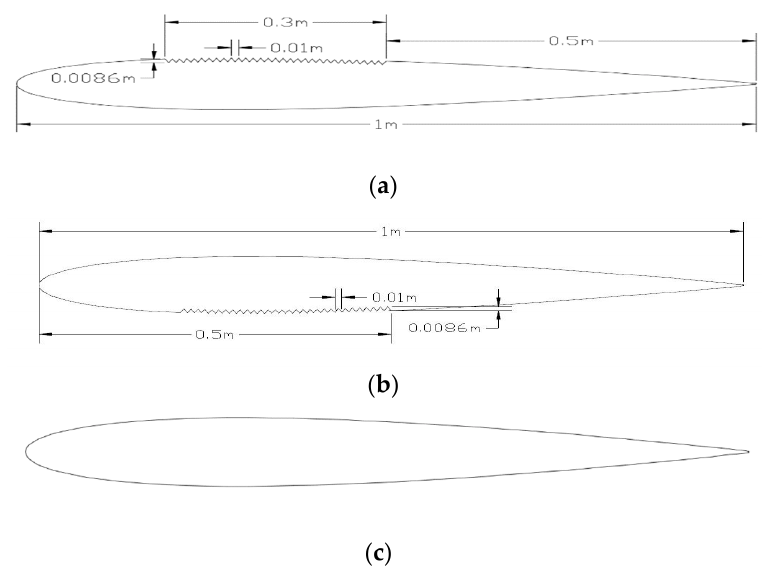
Figure 8. Three airfoils. ( a ) Triangular concave grooves on the suction side, ( b ) triangular concave grooves on the pressure side, and ( c ) NACA0012 airfoil.